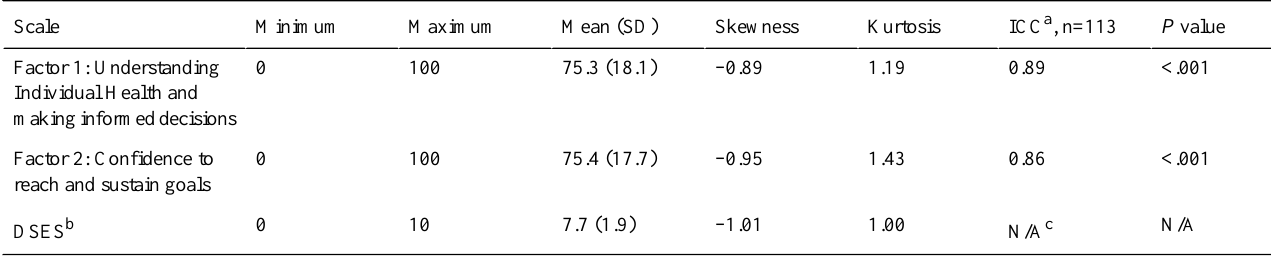
Table 3. Scale score descriptive statistics